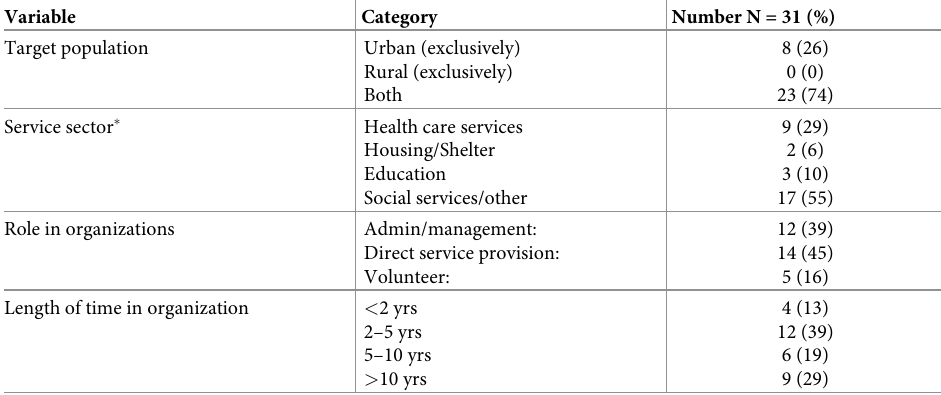
Table 2. Description of the sample of service providers who participated in the in-depth interviews.